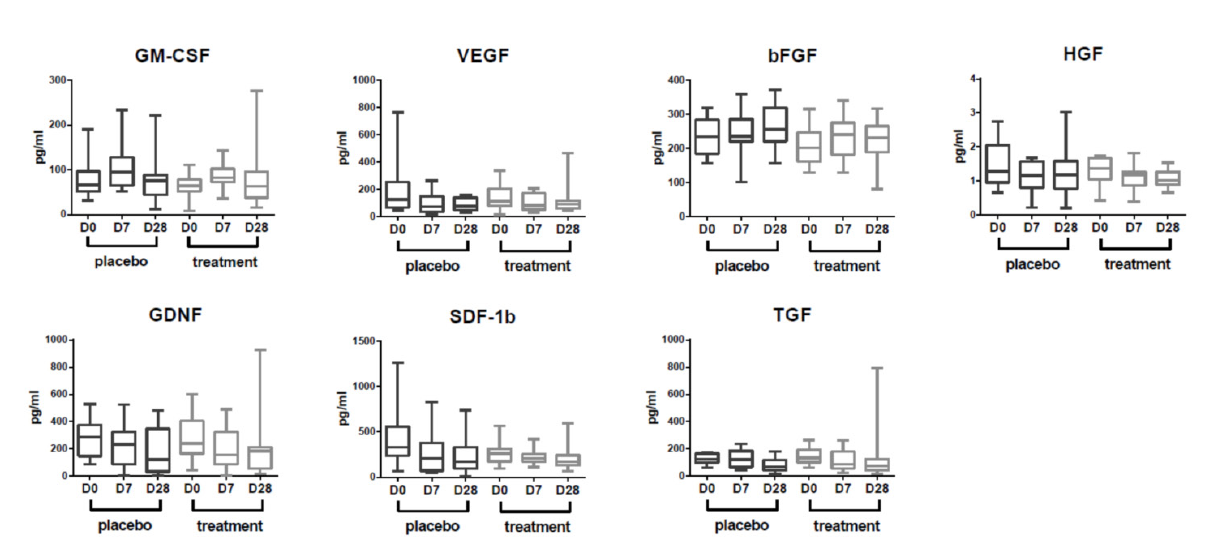
Fig. 2. Changes in the tested growth factor and cytokine levels on Days 0, 7, and 28 in serum of placebo-treated and ASC-CM- treated rabbits. There were no statistically significant